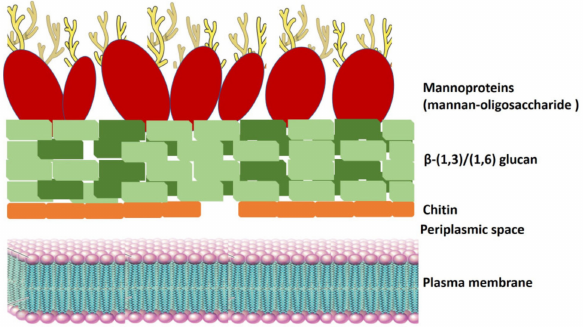
Figure 5. Schematic representation of the yeast cell wall. The yeast cell wall is composed of mannan–oligosaccharide (mannoproteins), complex polymers of β -(1,3) / (1,6) glucan, and chitin.